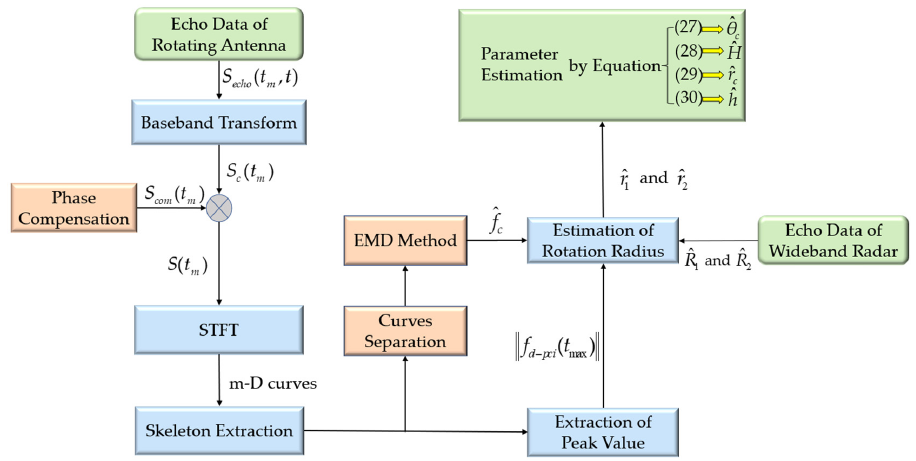
Figure 4. Flowchart of the proposed method.